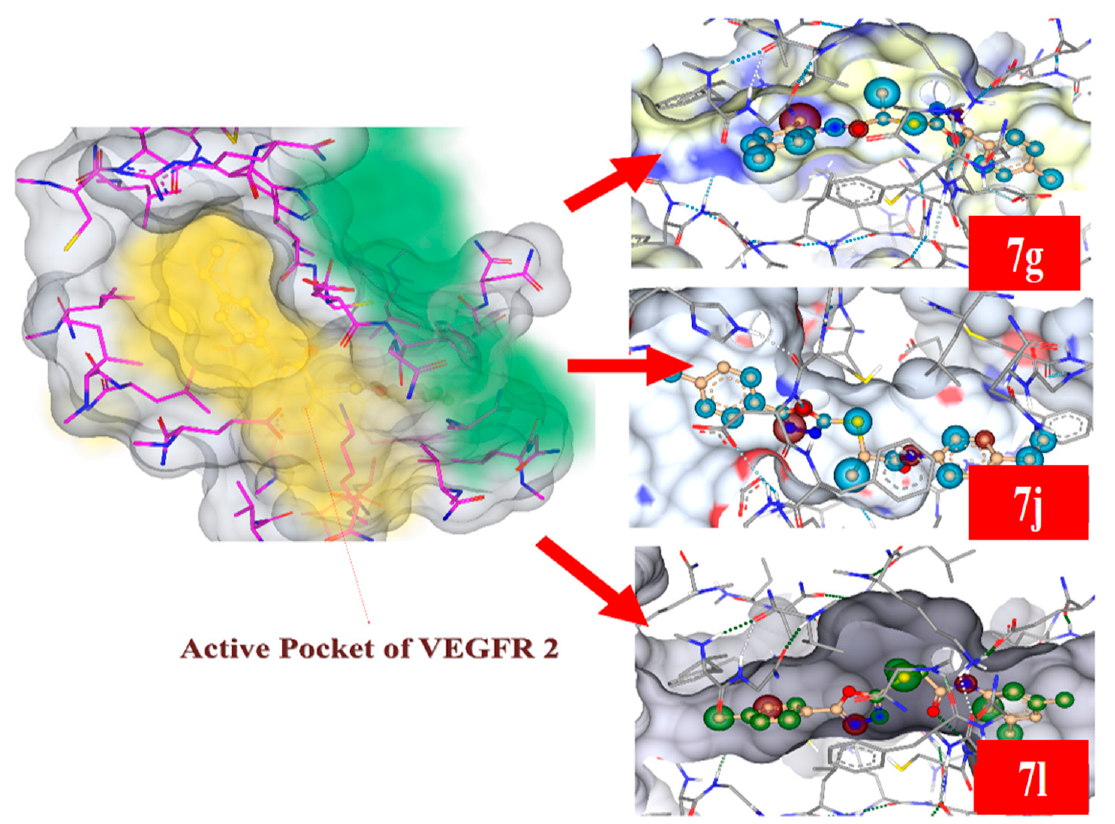
Figure 5. 3D diagram showing the binding interactions of 7g and 7j and 7l within the active pocket of Protein VEGFR2.